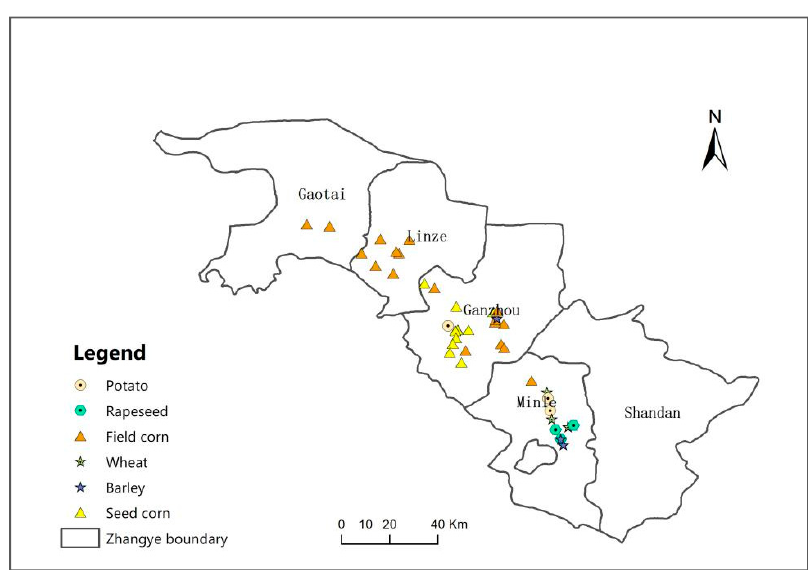
Figure 2. Distribution of crops in study area.